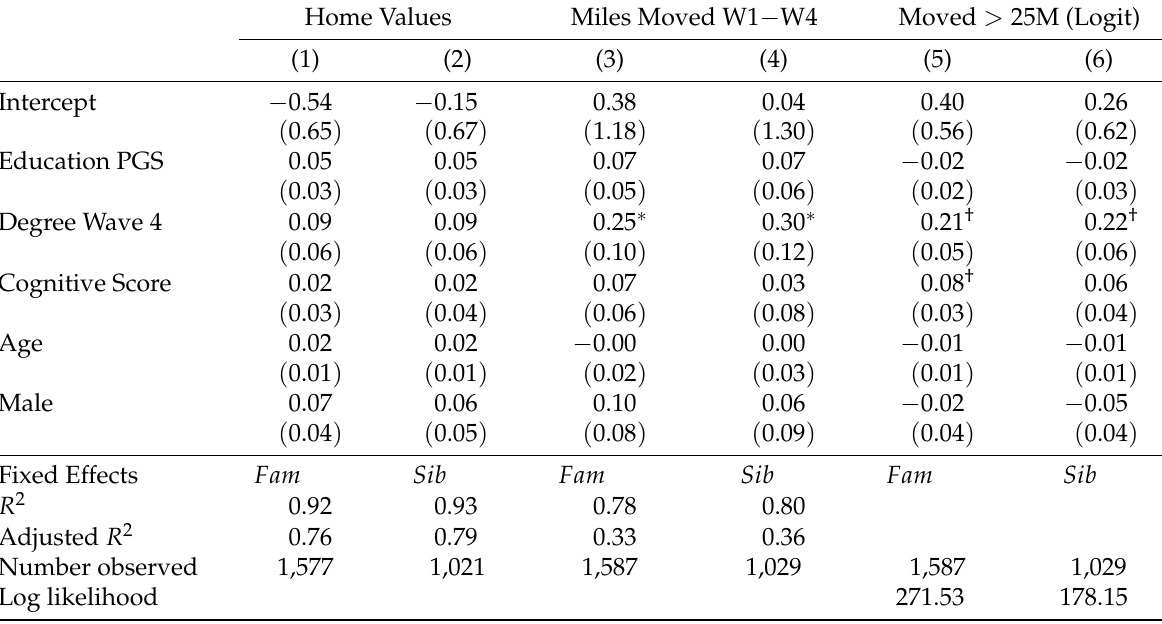
Table 3: Wave 4 neighborhood attainments; family and sibling fixed-effects